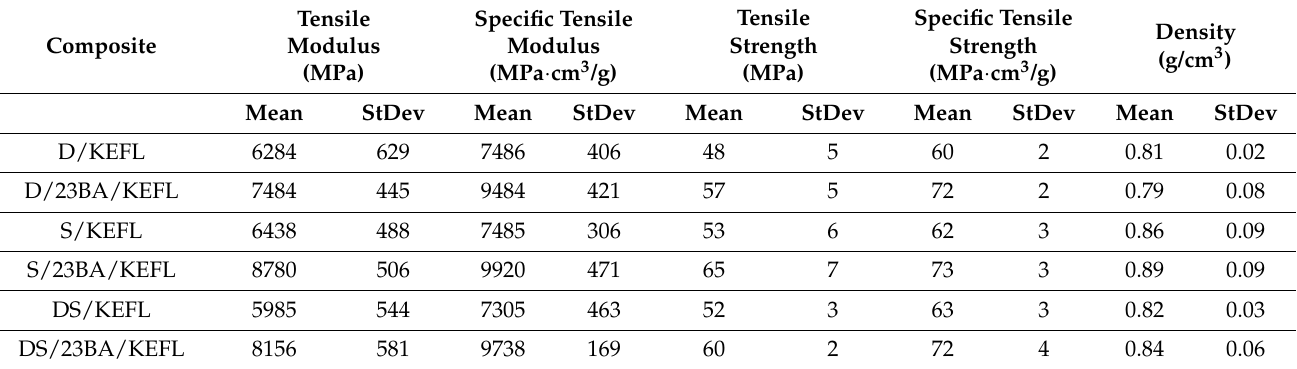
Table 7. Tensile analysis of composites.